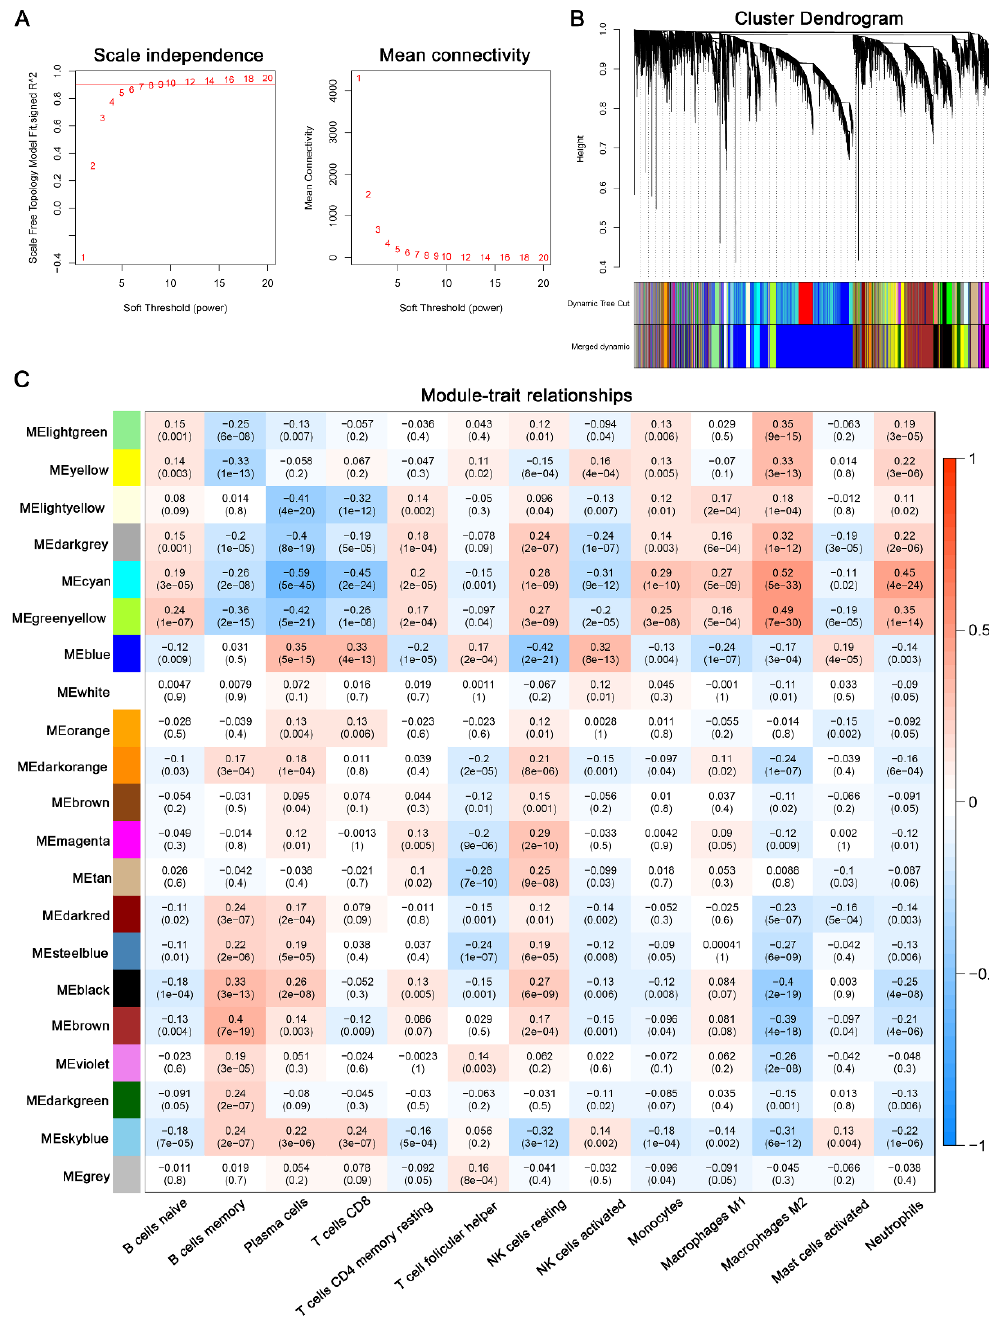
Figure 4. Weighted co-expression network analysis. ( A ) Analysis of the scale independence index (left) and the mean connectivity (right) for various soft-thresholding powers. ( B ) Clustering dendrogram of recognition modules. Each module was given an individual color as an identifier, including 21 different modules. ( C ) Heatmap of module–trait relationships between infiltrating immune cells and module eigengenes.